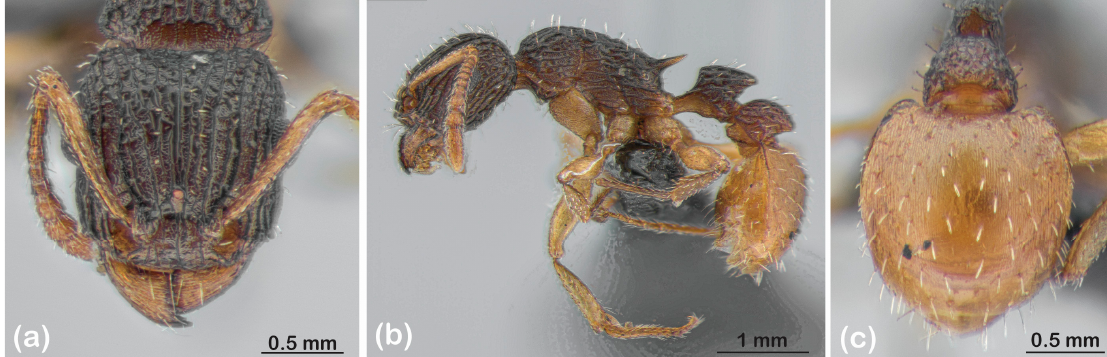
Figure 1. Tetramorium spininode . ( a ) Head in frontal view. ( b ) Lateral view. ( c ) Gaster in dorsal view. All images are of sequenced specimen OZBOL 6501-22, collected from the type